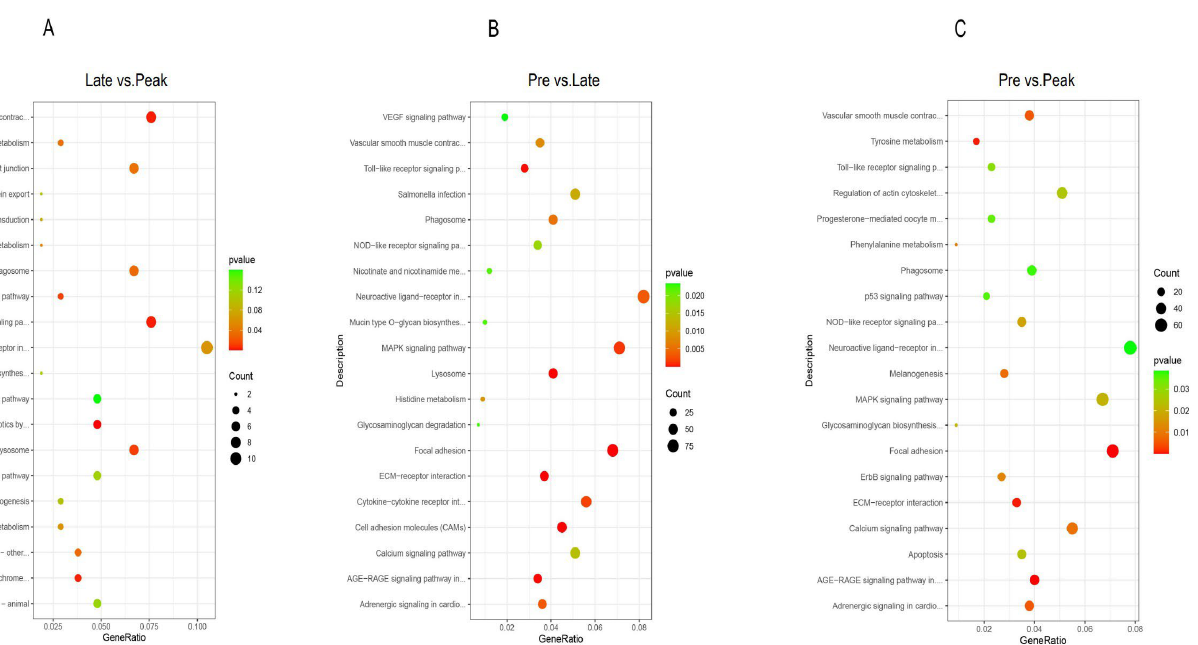
Figure 3. The GO enrichment bar graphs for the top 30 items in the ( A ) late vs. peak stage, ( B ) pre vs. late stage, and ( C ) pre vs. peak stage. (BP: biological process, CC: cellular component, MF: mo- lecular function).